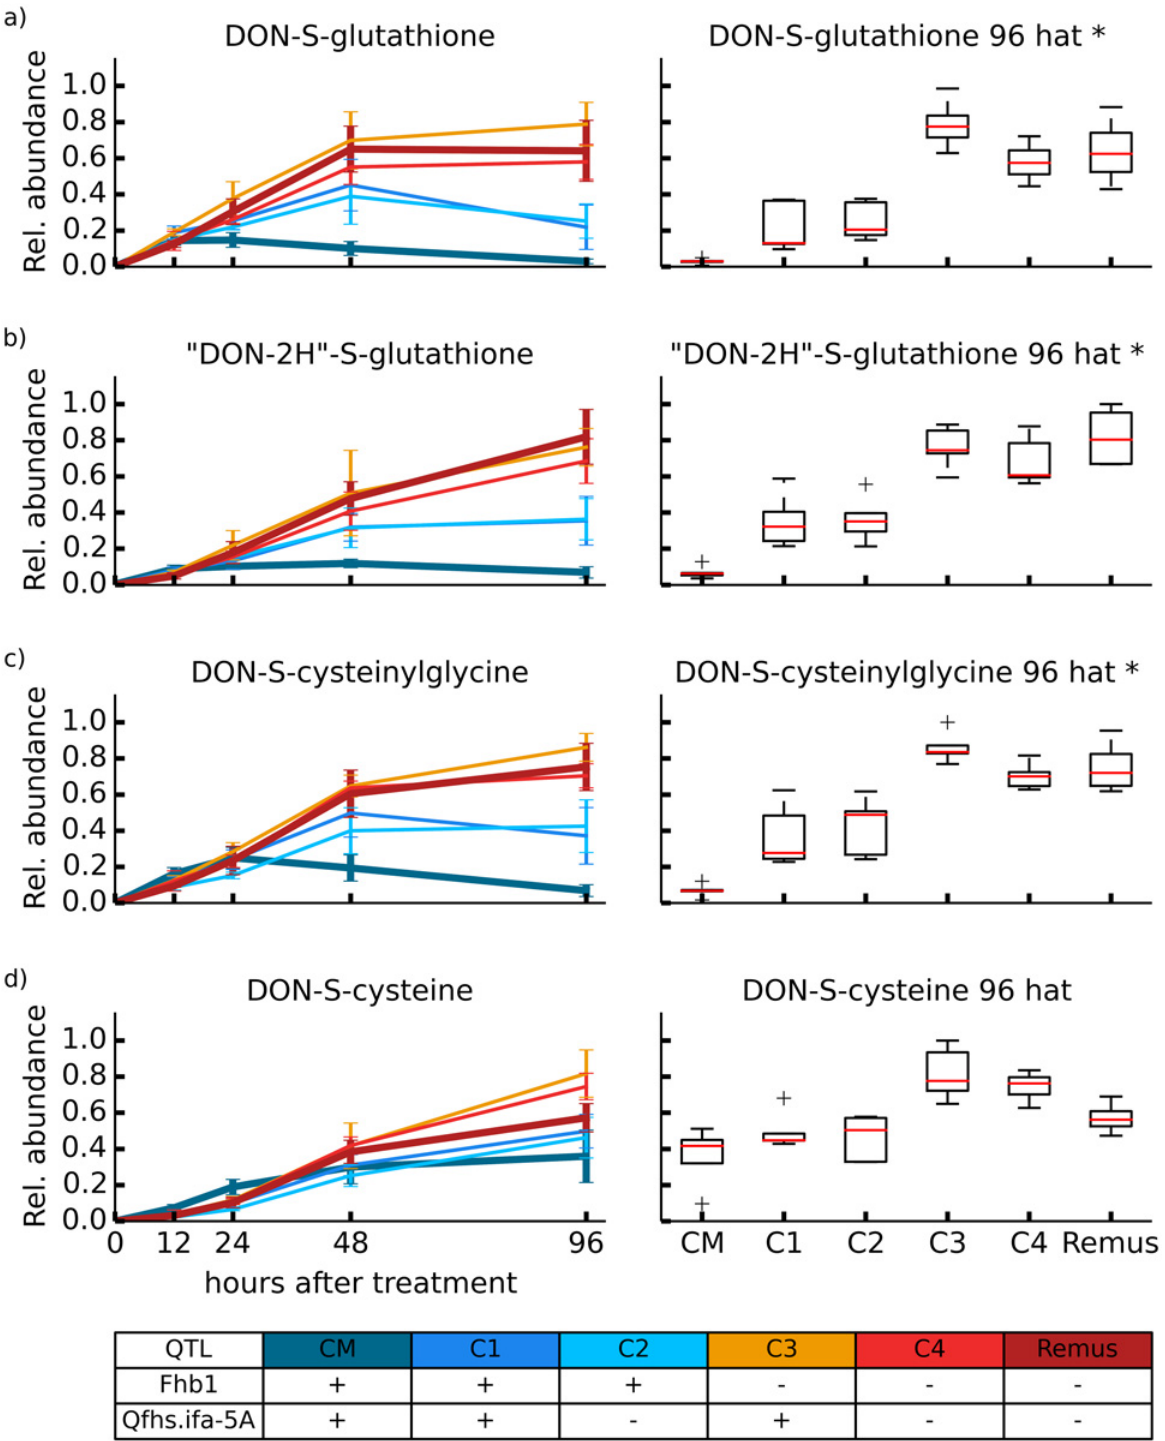
Fig 5. Detoxification of DON via glutathione pathway. Glutathione pathway related detoxification of DON. Relative formation rates for biotransformation products DON-S-glutathione (a) and its related degradation products “ DON-2H ” -S-glutathione (b), DON-S-cysteinylglycine (c) and DON-S-cysteine (d). Additionally, for each biotransformation product boxplots for relative metabolite abundance observed 96 h after DON treatment were generated. * Significantly differing biotransformation product levels between wheat lines with and without resistance QTL Fhb1 based on a non-paired t-test (5% global significance